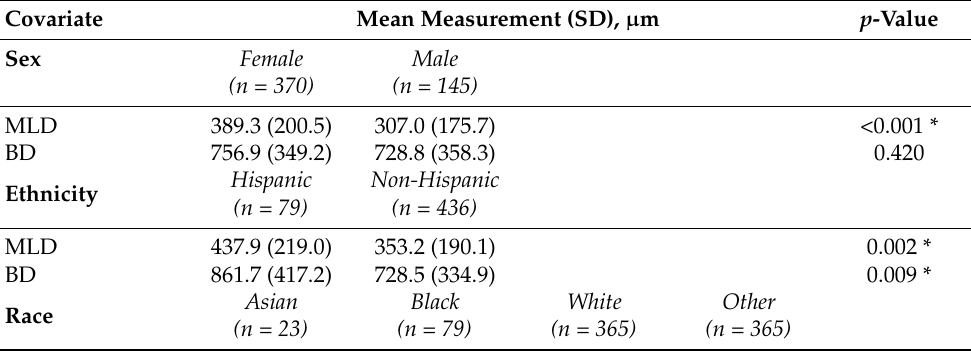
Table 4. Mean MLD and BD categorized by ethnicity, race, preferred language, and diabetes